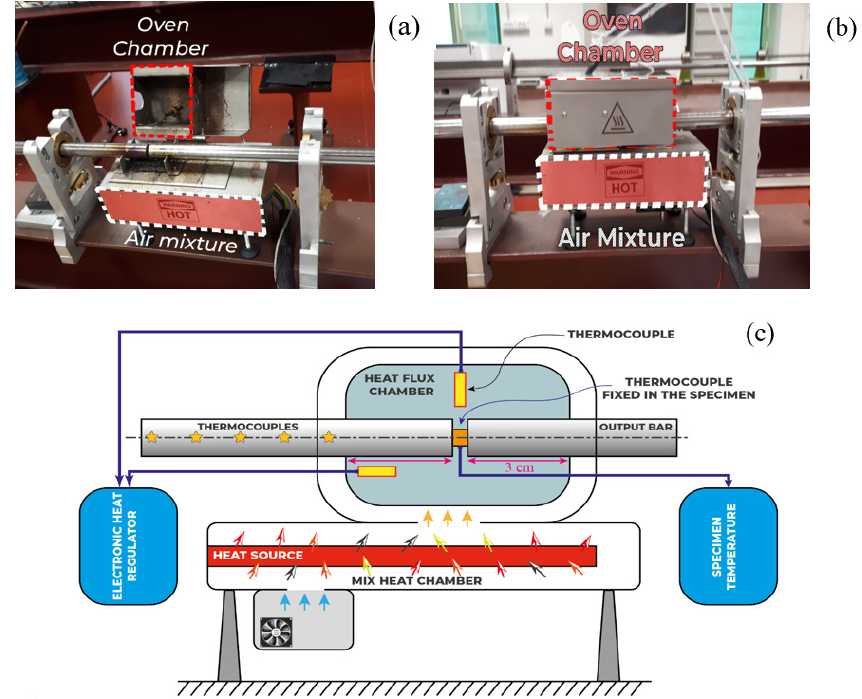
Figure 6. ( a ) Hopkinson pressure bars used during dynamic tests with a thermal chamber; ( b ) description of the internal part and ( c ) description of the air flowing.